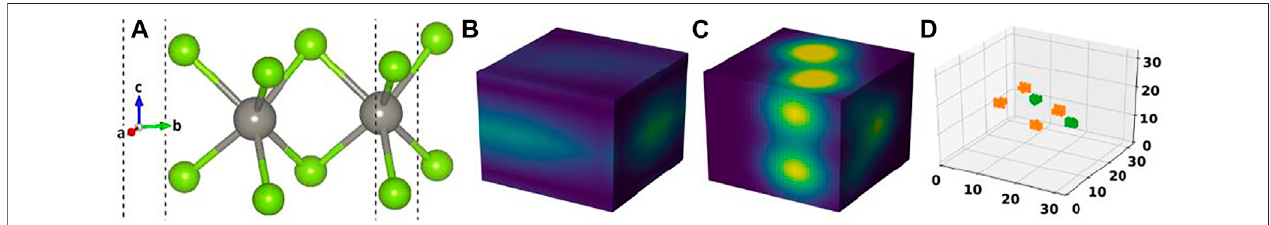
FIGURE 1 | (A) Crystal structure of a material in our dataset, (B) its cell image, (C) its basis image, and (D) the elements matrix.